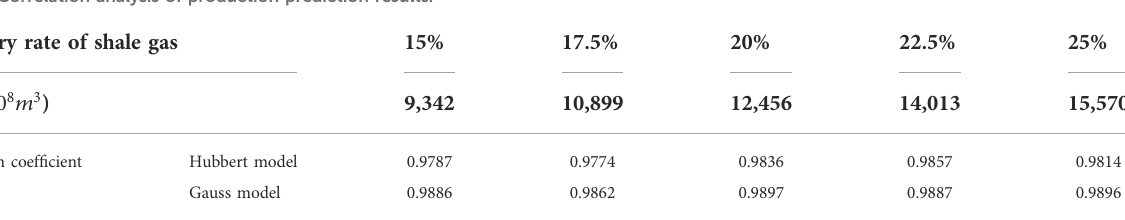
TABLE 1 Correlation analysis of production prediction results.